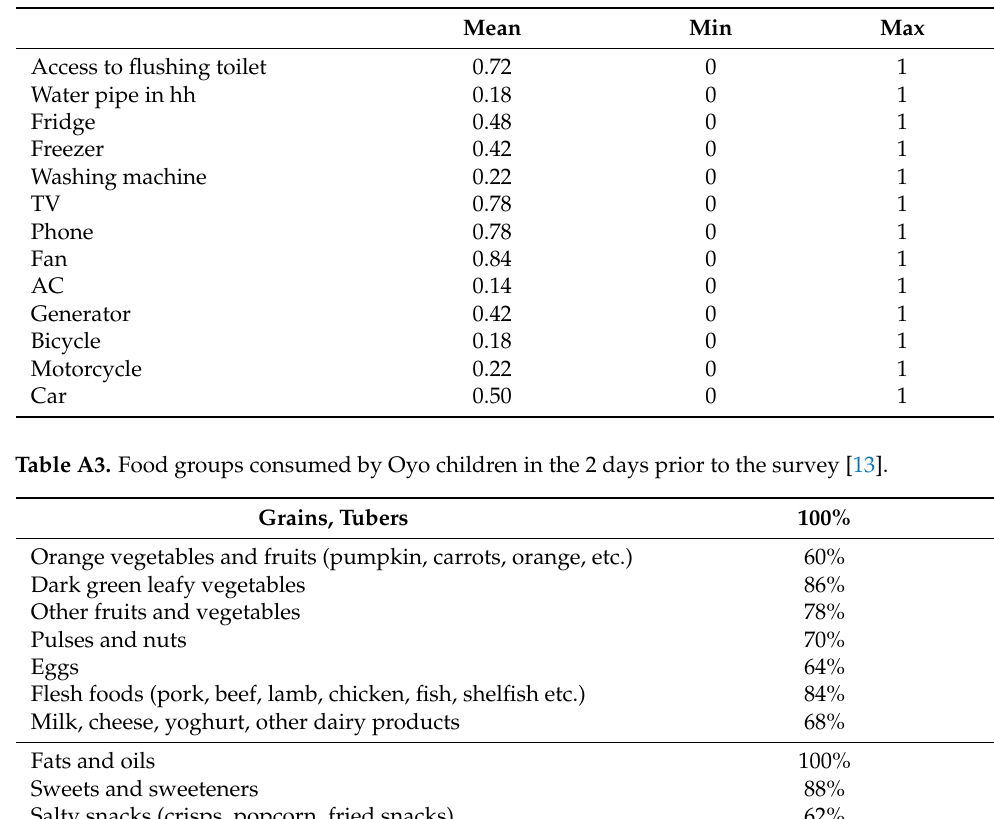
Flesh foods (pork, beef, lamb, chicken, fish, shelfish etc.)